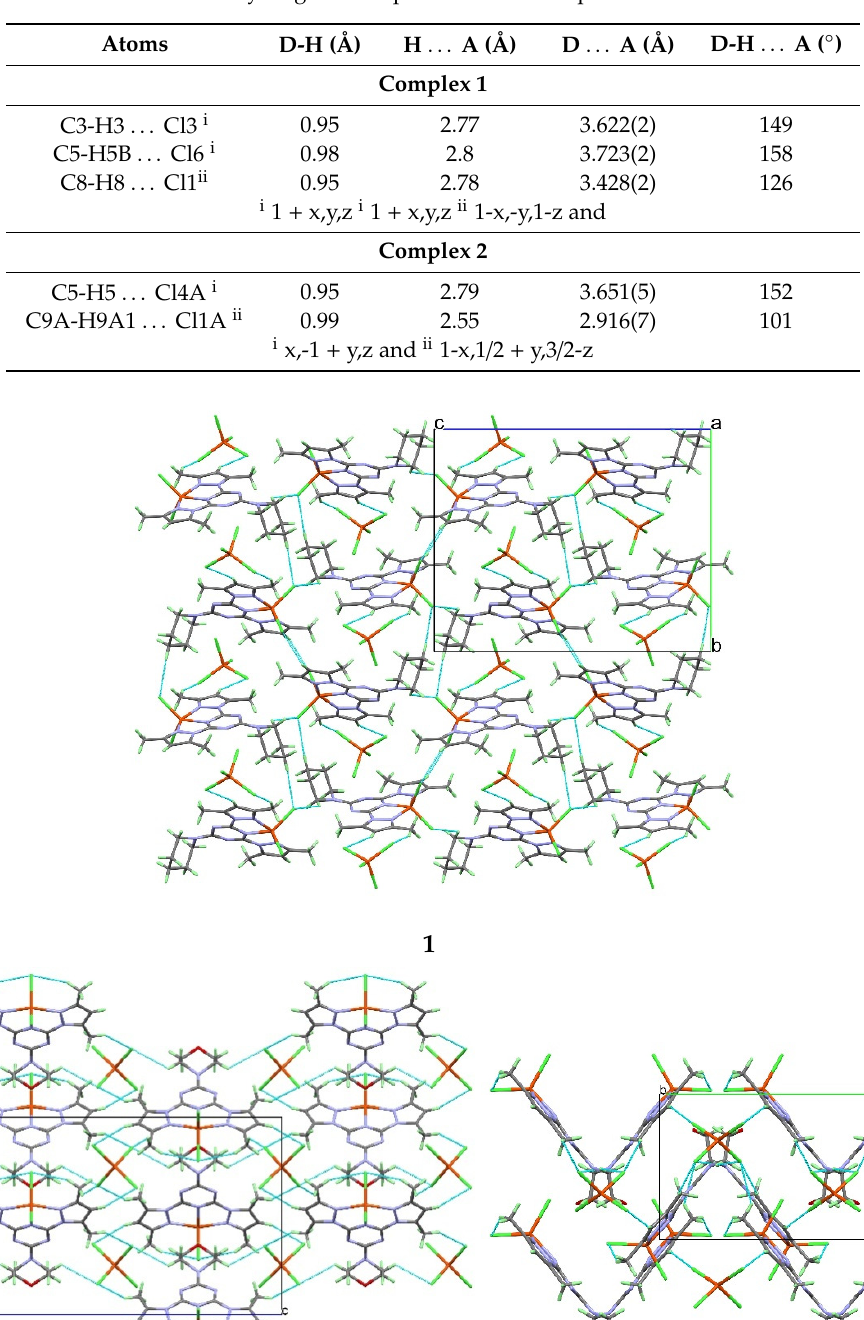
Table 3. Hydrogen bond parameters of complexes 1 and 2 .